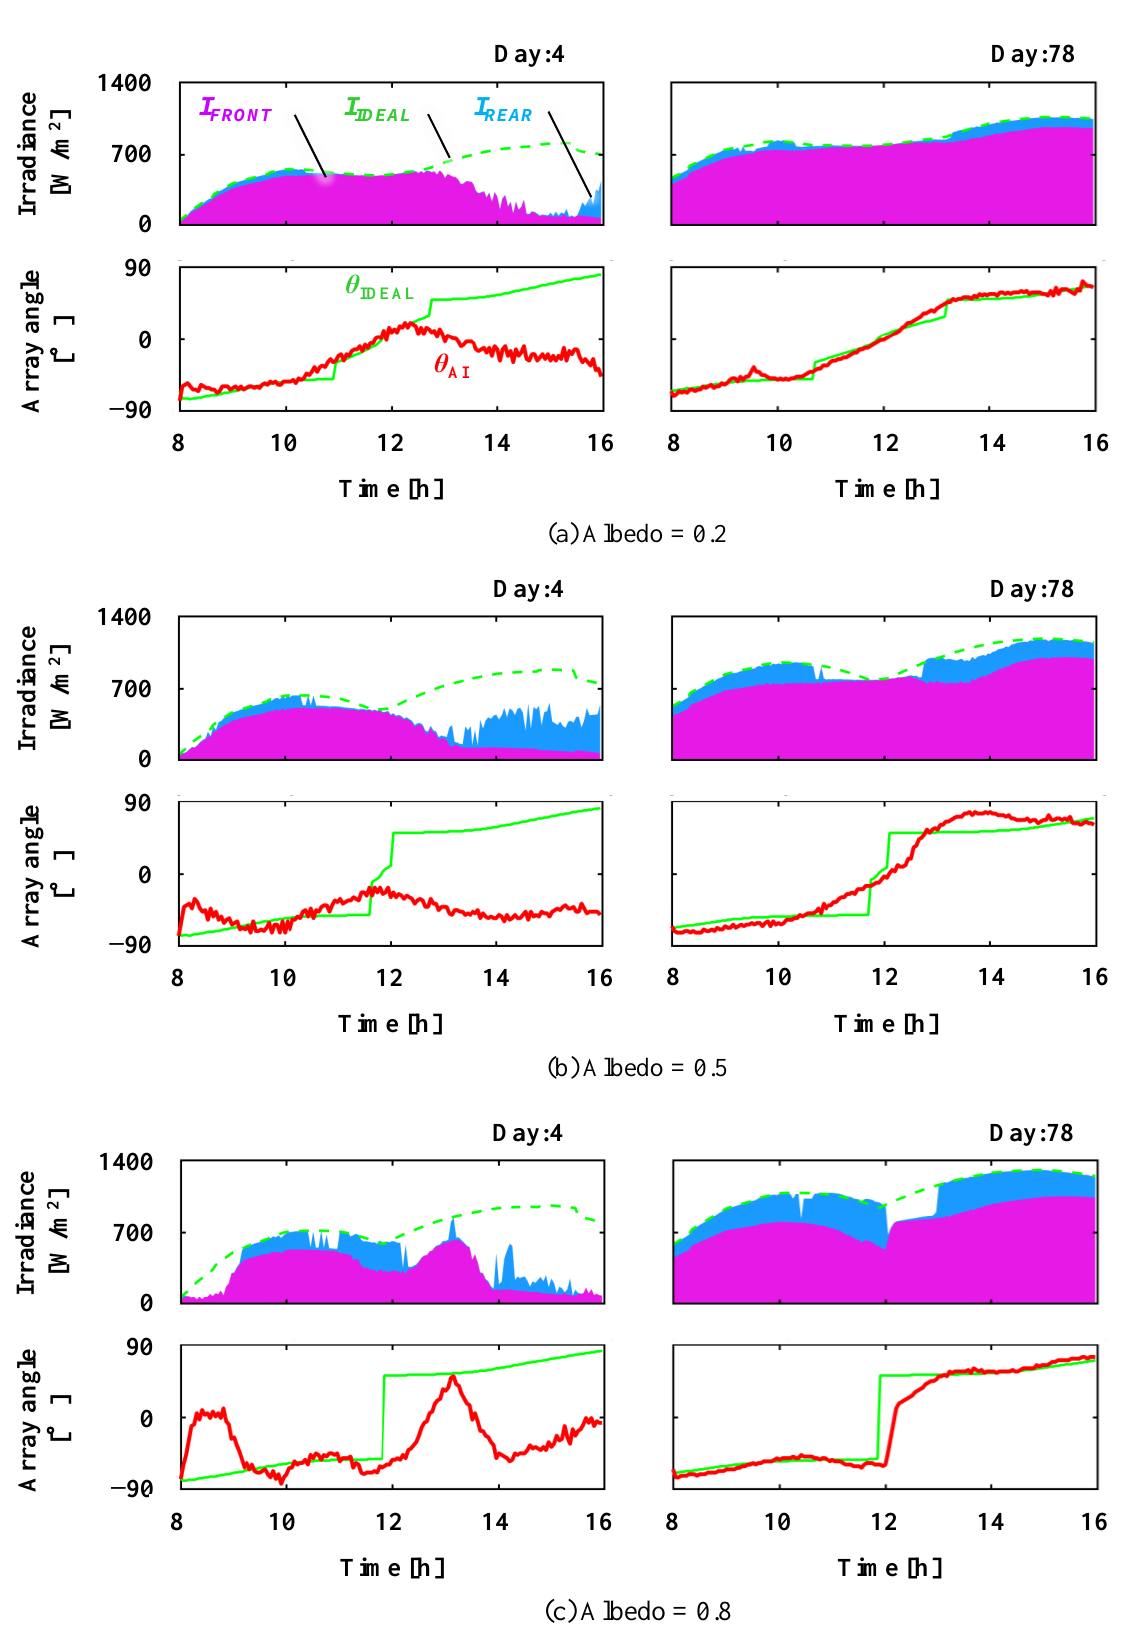
Figure 9. Comparison of time variation of irradiance and array tilt angle for AI and ideal controls on days 4 and 78. Both days were sunny (RUN 1).